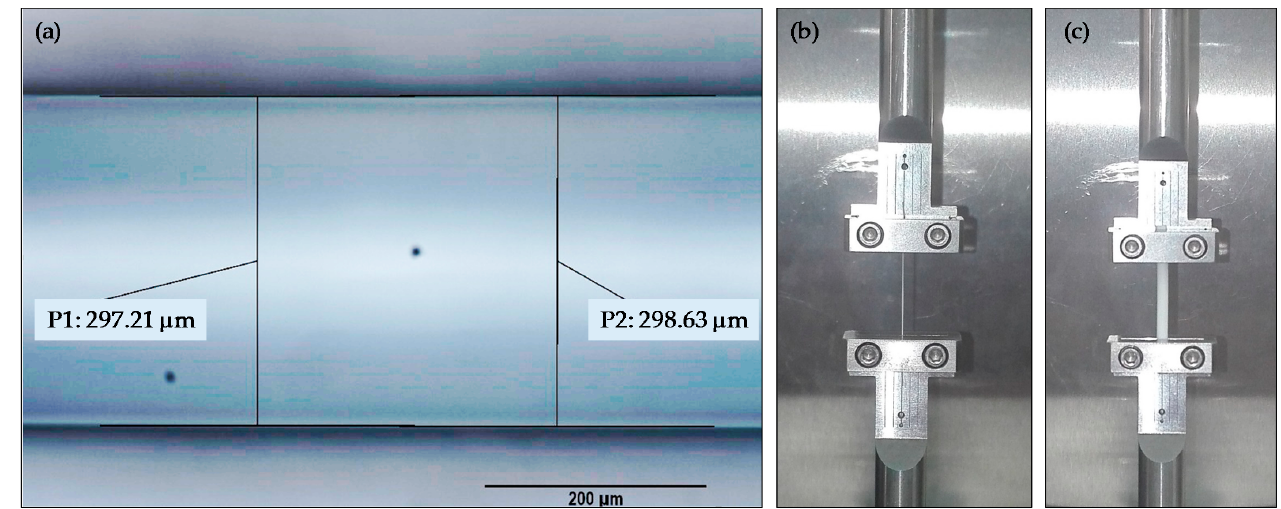
Figure 1. ( a ) Extruded TPU diameter measuring using the image analyser; ( b ) mechanical testing of an extruded filament sample; ( c ) mechanical testing of a feedstock sample.